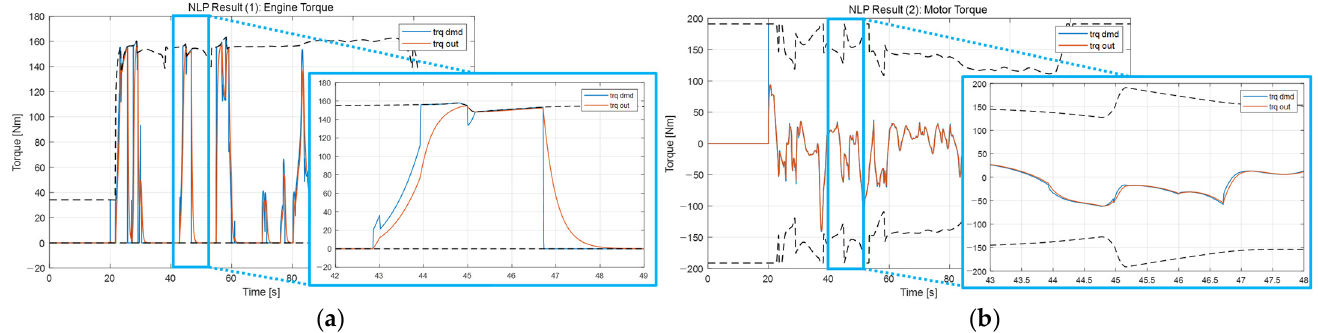
Figure 12. Result of NLP: ( a ) ICE torque; ( b ) EM torque. (blue = state/red = input/black = maxi- mum/minimum torque constraints.